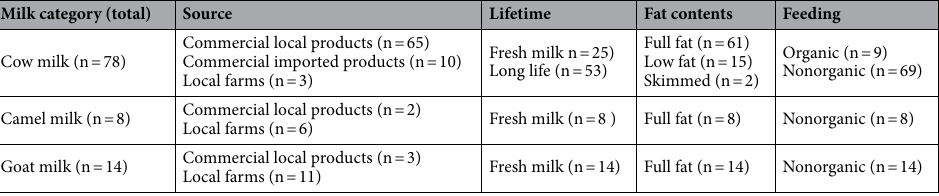
Table 2. Milk sample